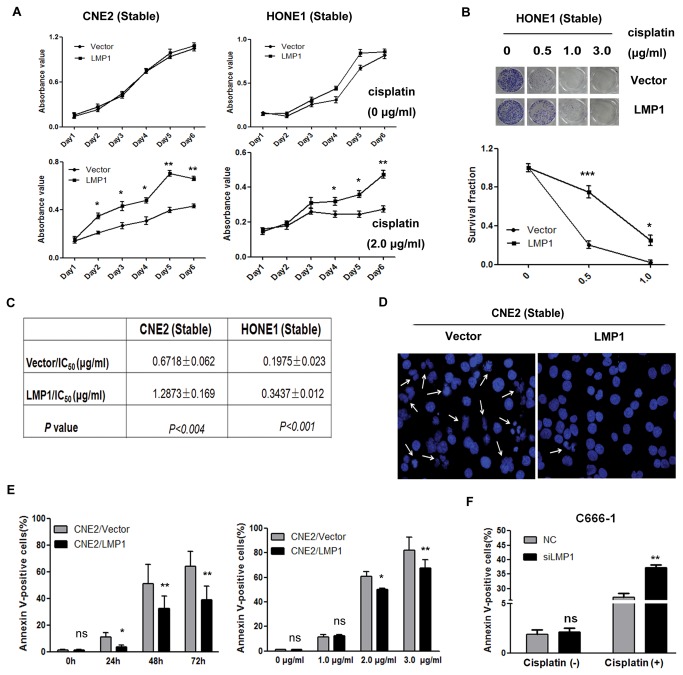
LMP1 confers resistance to cisplatin in NPC cells.(A) CNE2 and HONE1 stable cell lines were treated with 0 or 2.0 μg/ml cisplatin. The MTT assay was used to determine the cell proliferation every 24 h for six days (* P < 0.05; ** P < 0.01 vs vector control cells). (B) Colony formation assays were performed for HONE1/LMP1 and HONE1/Vector cells, which were treated with the indicated doses of cisplatin. The upper panel shows the images of the colonies stained by crystal violet. The lower panel is the survival fraction from three independent experiments (* P < 0.05, *** P < 0.001 vs vector control cells). (C) Stably transfected cell lines were treated with various concentrations of cisplatin for 72 h to determine the IC50 of cisplatin. The IC50 values are presented as the means ± SD of three independent experiments. The IC50 is the concentration of chemotherapeutic drug (e.g., cisplatin) that causes a 50% inhibition of tumor cell growth. (D) The analysis of apoptosis by Hoechst-33342 staining for disintegrated nuclei in CNE2/LMP1 and CNE2/Vector cells treated with 3 μg/ml cisplatin for 72 h. Representative images (200x) at the indicated time points are shown. The white arrows indicate the cells with obviously broken nuclei. (E) The flow cytometry analysis of apoptosis by Annexin V/PI staining in CNE2/LMP1 and CNE2/Vector cells treated with 3 μg/ml cisplatin for indicated time points (left panel) or with cisplatin at various concentrations for 72h (right panel). The histograms shown are the means ± SD from three independent experiments (ns, not significant; * P < 0.05; ** P < 0.01 vs vector control cells). (F) C666-1 cells were transfected with siLMP1 or control siRNA (NC) for 24 h, exposed to 4 μg/ml cisplatin for 48 h or not and assayed to detect the apoptosis rate. The histograms shown are the means ± SD of three independent experiments (ns, not significant; ** P < 0.01 vs control siRNA transfected cells).